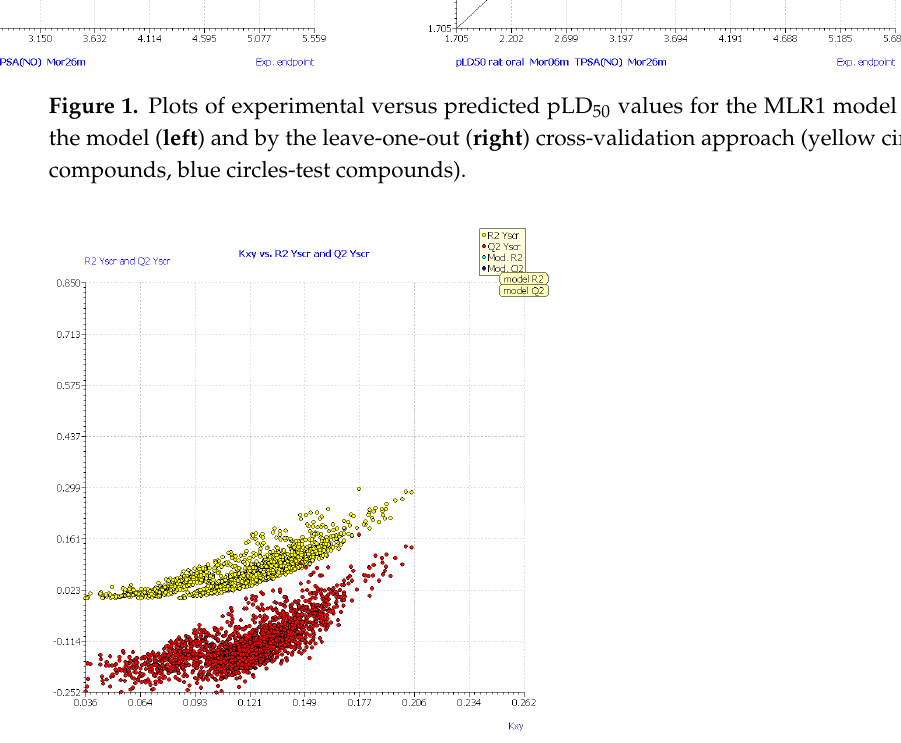
Figure 2. Y-scramble plots for the MLR1 model.